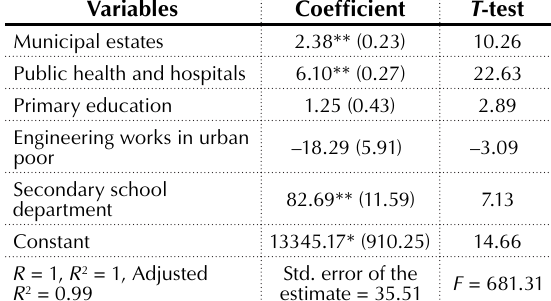
Table 6. Regression result of revenue receipts